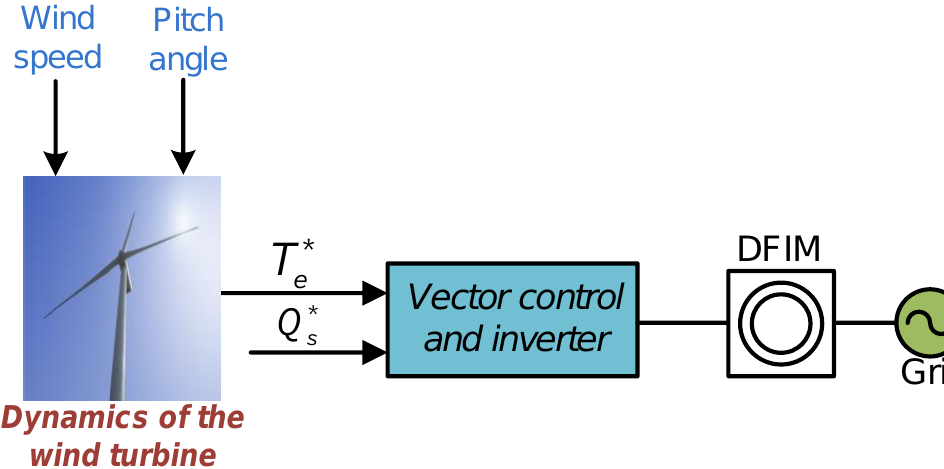
Figure 10. DFIM based wind turbine